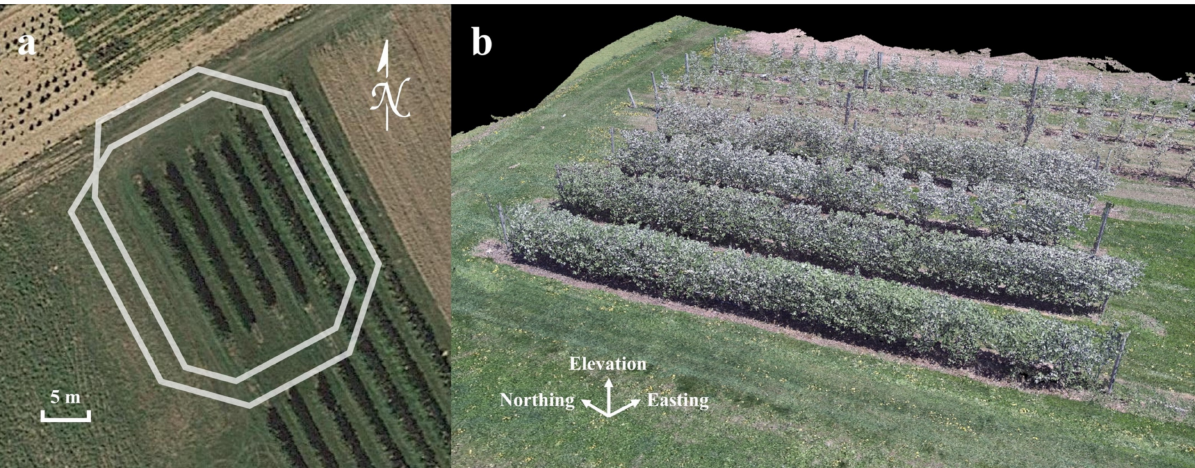
Figure A1. The apple orchard where sample RGB image data were collected: ( a ) the flight path of the UAV flight mission; ( b ) the reconstructed apple orchard point cloud using the sample